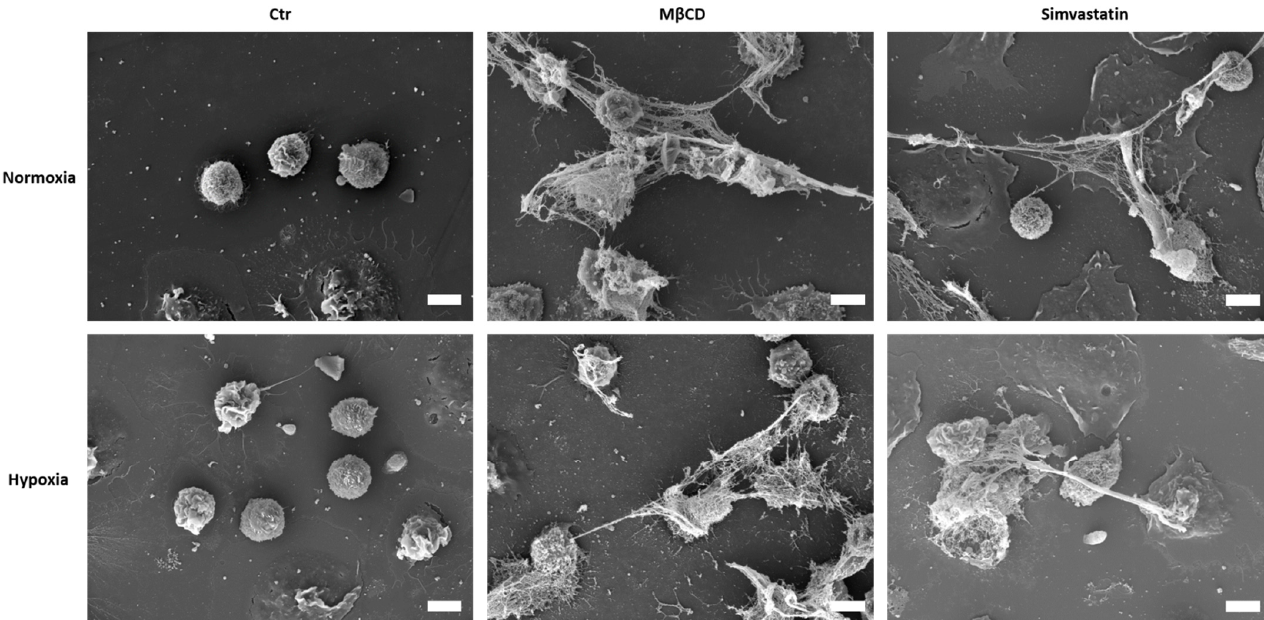
Figure 5. Scanning electron micrographs of human neutrophils, which were incubated under hypoxic or normoxic conditions for 3 h with respective stimuli. Under both oxygen conditions, NET formation can be observed for M β CD and Simvastatin stimulated cells, with typical offshoots. Scale bar: 10 µ m.